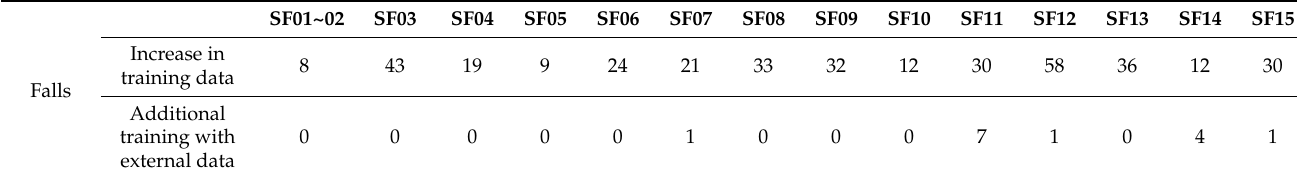
Table 6. False alarms of falls in the external test with ANN and